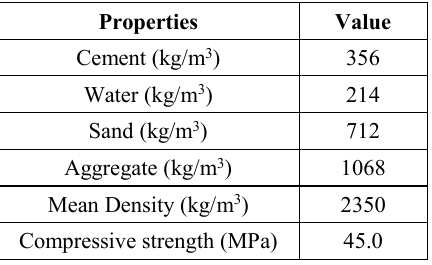
Fig. 1. Concrete sample. Table 1. Composition and mechanical properties of